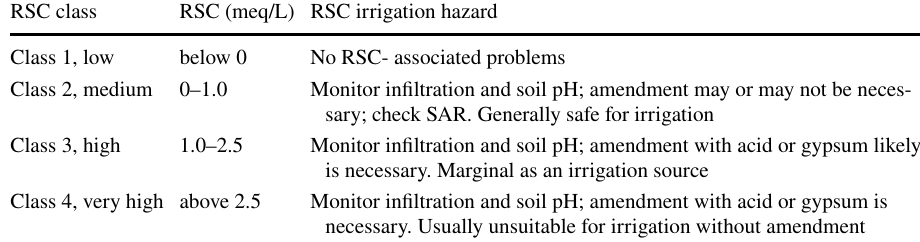
Table 3 Suitability of water for irrigation with respect to RSC value source: (PNWE